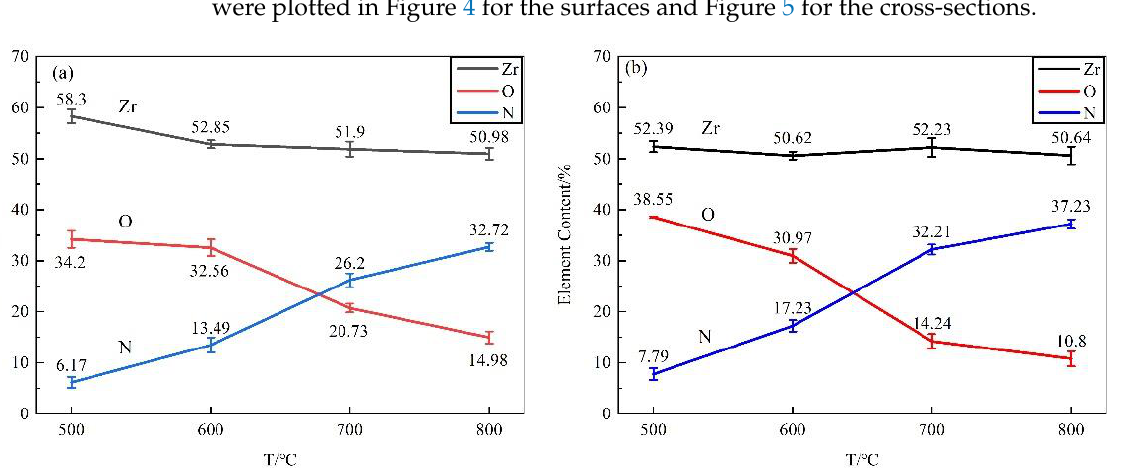
Figure 3. Cross-sectional SEM images of zirconium hydride with nitride film ( a ) N 2 , 20 h, 500 ◦ C; ( b ) N 2 , 20 h, 600 ◦ C; ( c ) N 2 , 20 h, 700 ◦ C; ( d ) N 2 , 20 h, 800 ◦ C; ( e ) N 2 , 5 h, 800 ◦ C; ( f ) N 2 + H 2 , 20 h, 500 ◦ C; ( g ) N 2 + H 2 , 20 h, 600 ◦ C; ( h ) N 2 + H 2 , 20 h, 700 ◦ C; ( i ) N 2 + H 2 , 20 h, 800 ◦ C.